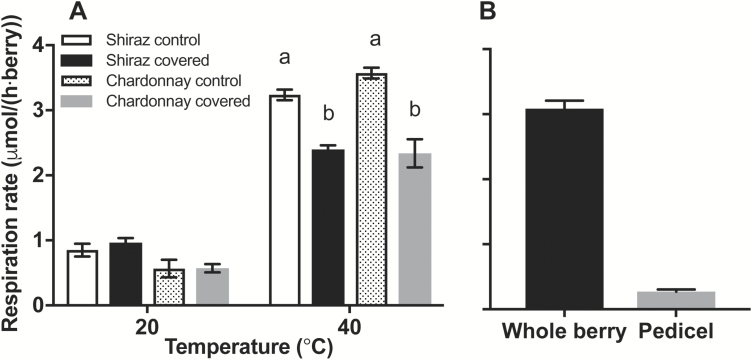
Role of the pedicel in oxygen diffusion as a function of temperature. (A) Respiration of Chardonnay (86 DAA) and Shiraz (77 DAA) berries (per berry basis) at 20 °C and 40 °C with pedicels attached (the 2016–2017 season). Silicone grease covered the lenticels on the pedicel (covered berries). At 20 °C, no significant difference in apparent berry respiration was found between control and pedicel-covered berries for both cultivars. Different lower case letters indicate significant differences between treatments at 40 °C within each cultivar (two-way ANOVA, P<0.0001). Shiraz and Chardonnay showed a decrease of 839.7 ± 101.8 nmol h–1 and 1377.3 ± 161.3 nmol h–1 per berry in respiration at 40 °C (26% and 39% decrease), respectively. (B) Respiration rate of whole berry including attached pedicel and respiration of separated pedicels for Chardonnay at 40 °C. The pedicel accounted for 9% of the whole berry respiration rate. Data are means ±SE, n=3.